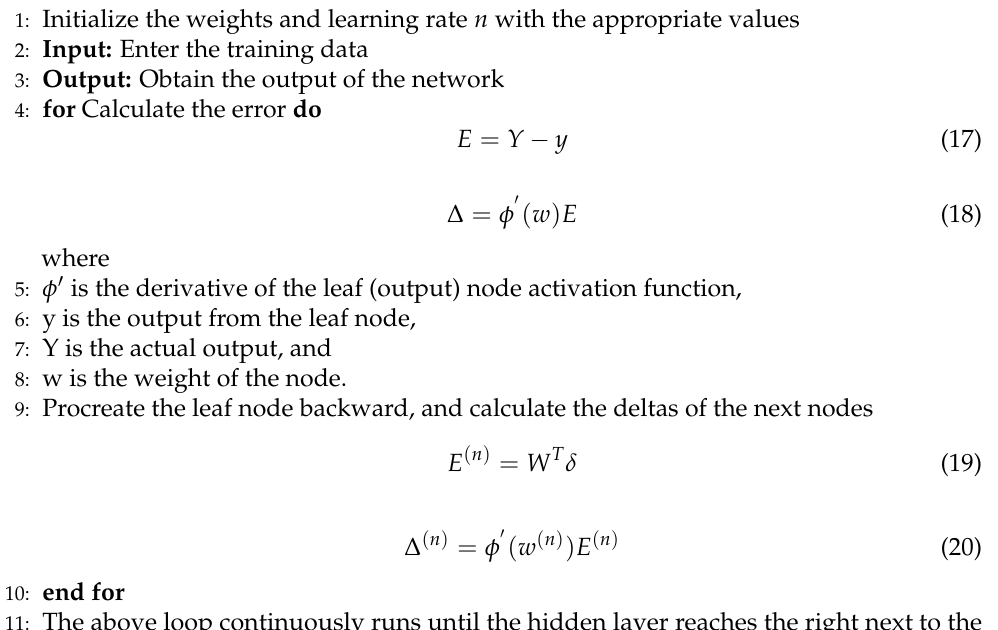
Algorithm 4 The Neural Networks using Back-propagation Method